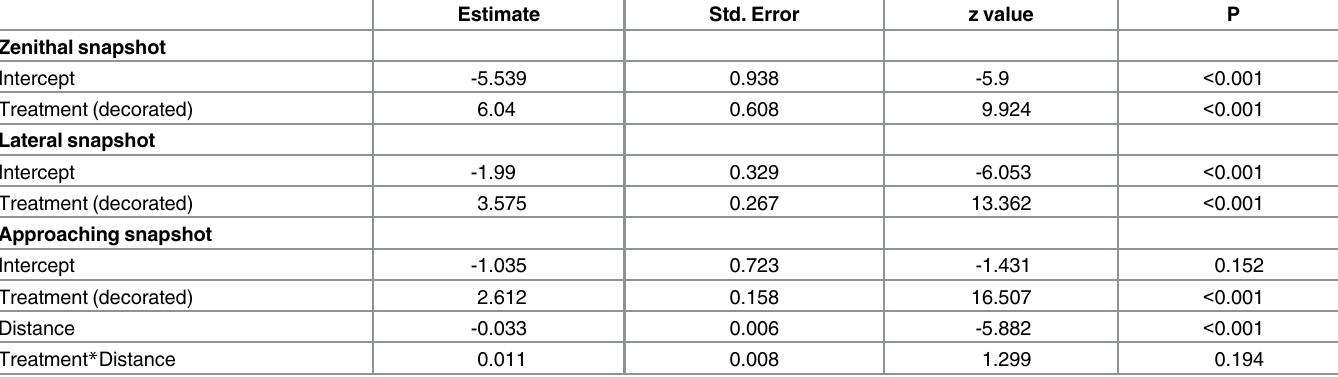
Table 1. Nest detection probability by human observers in relation to decoration treatment (decorated and non-decorated) and distance to the nest. Three models were run to analyses independently the detectability of the nests from: zenithal snapshots (50m AGL), lateral snapshots (15m and 10m